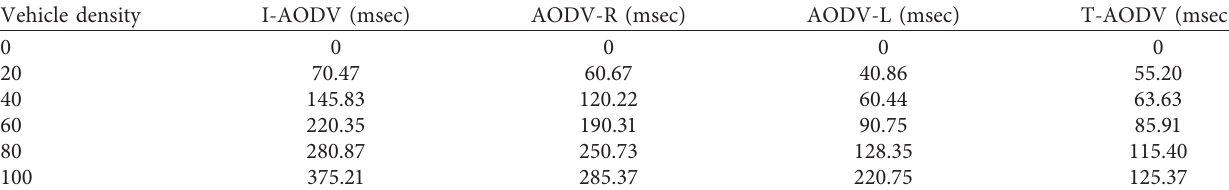
Table 3: Comparison of end-to-end delay for different